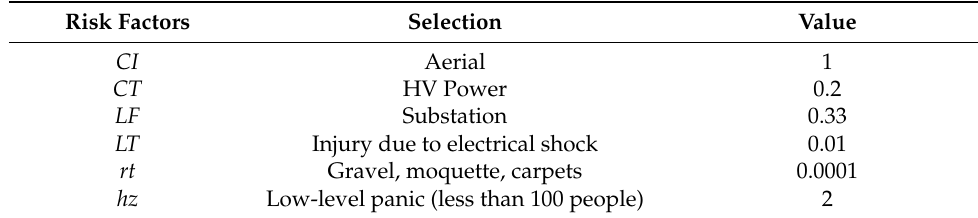
Table 10. Common Risk